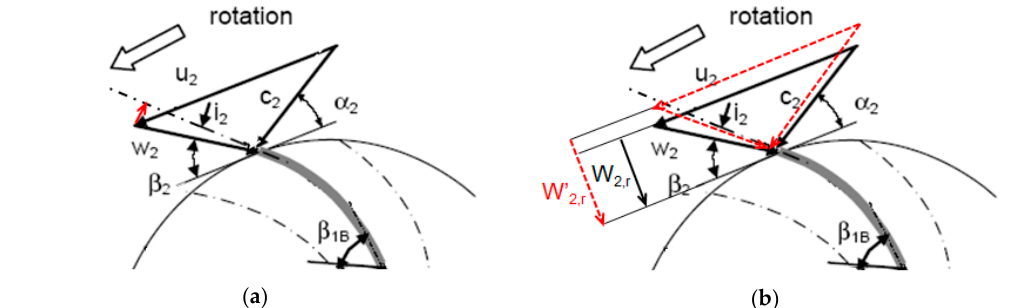
Figure 5. Runner losses: ( a ) The flow incidence loss; ( b ) Variation of the radial component of the inlet relative velocity.